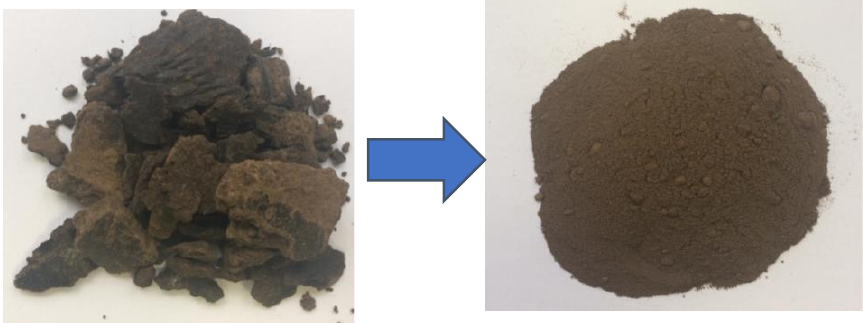
Figure 5. Initial and milled to a fraction of 0.1 ÷ 1 mm core material. Table 4. Mineral composition of the